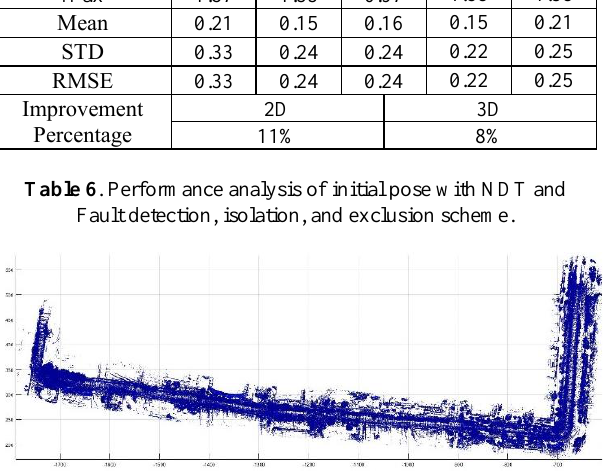
Figure 12. Error analysis of trajectories